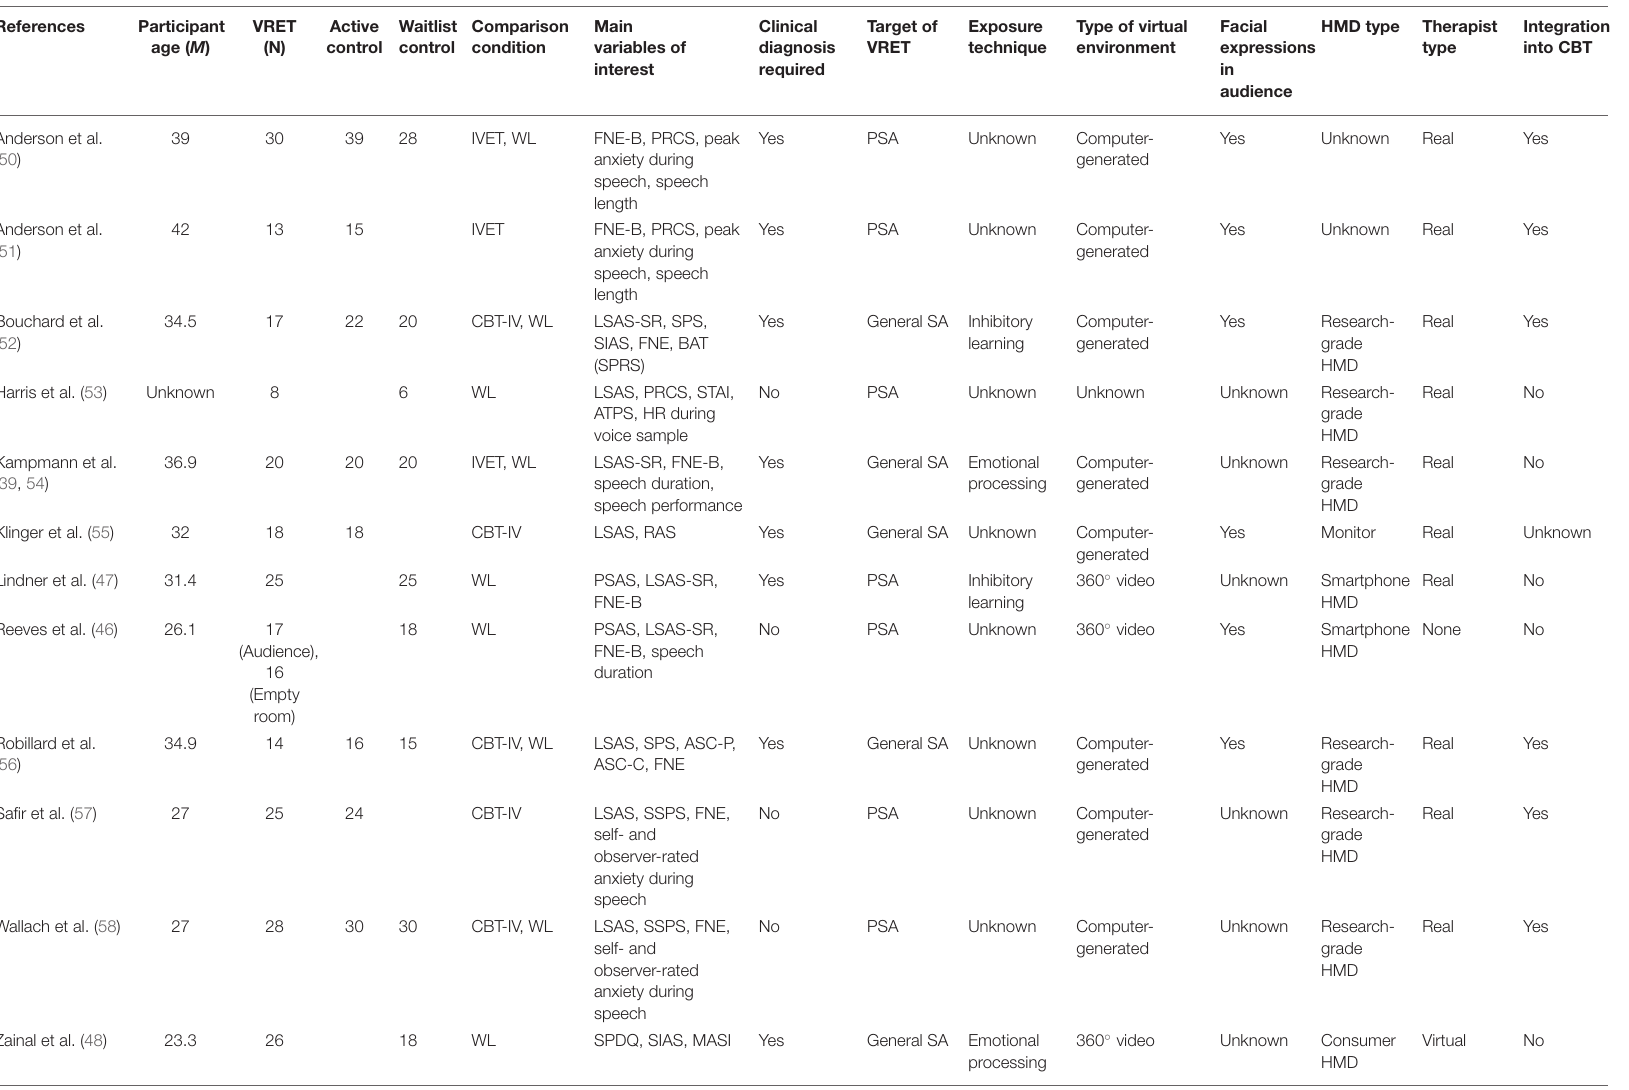
TABLE 1 | Studies included in scoping review, methodological details, and key features of VRET protocols.